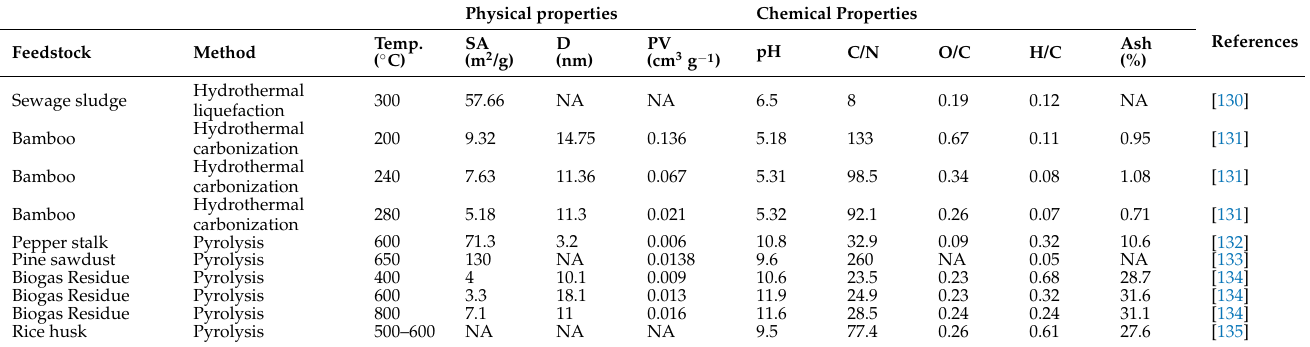
Table 2. Biochar produced from various feedstocks and their physiochemical